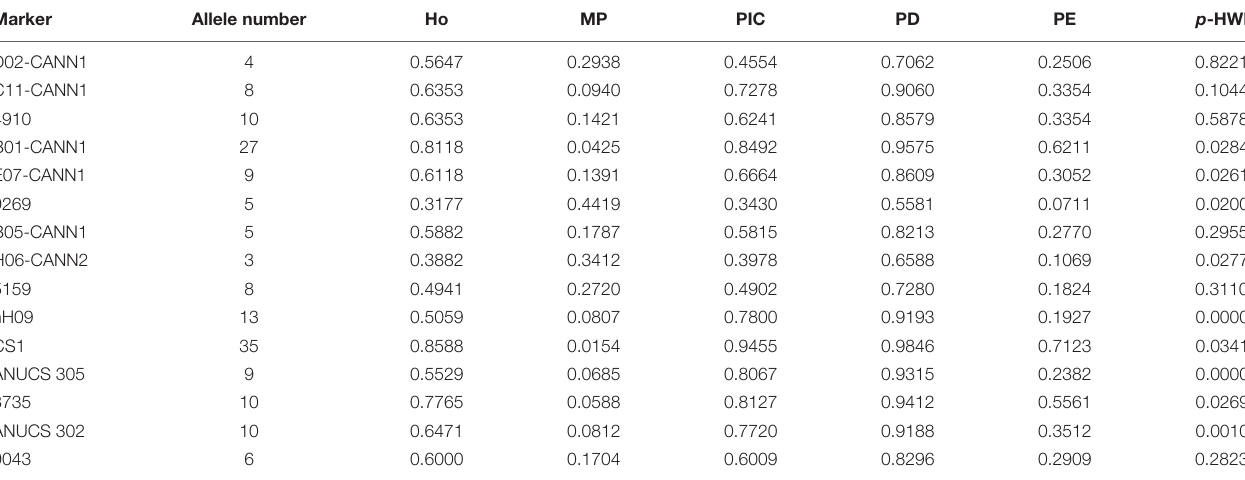
TABLE 3 | Parameters for 15 autosomal STRs in Cannabis sativa ( N =